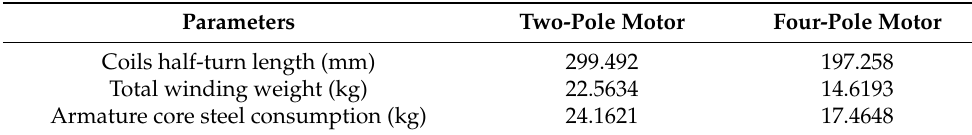
Table 6. Structure parameter value comparison of stator winding coils for HSPMM. Parameters